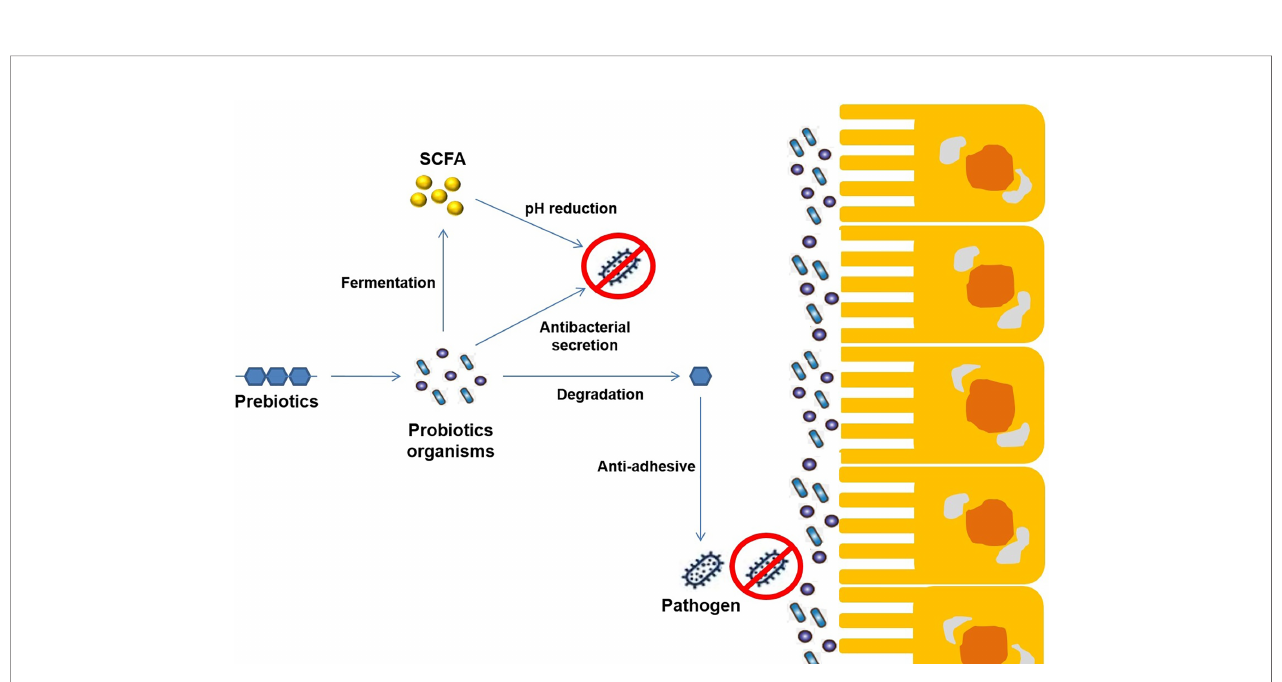
FIGURE 6 | Schematic representation of the mechanism of synergetic activity (Probiotics+ Prebiotics) towards different enteropathogenic